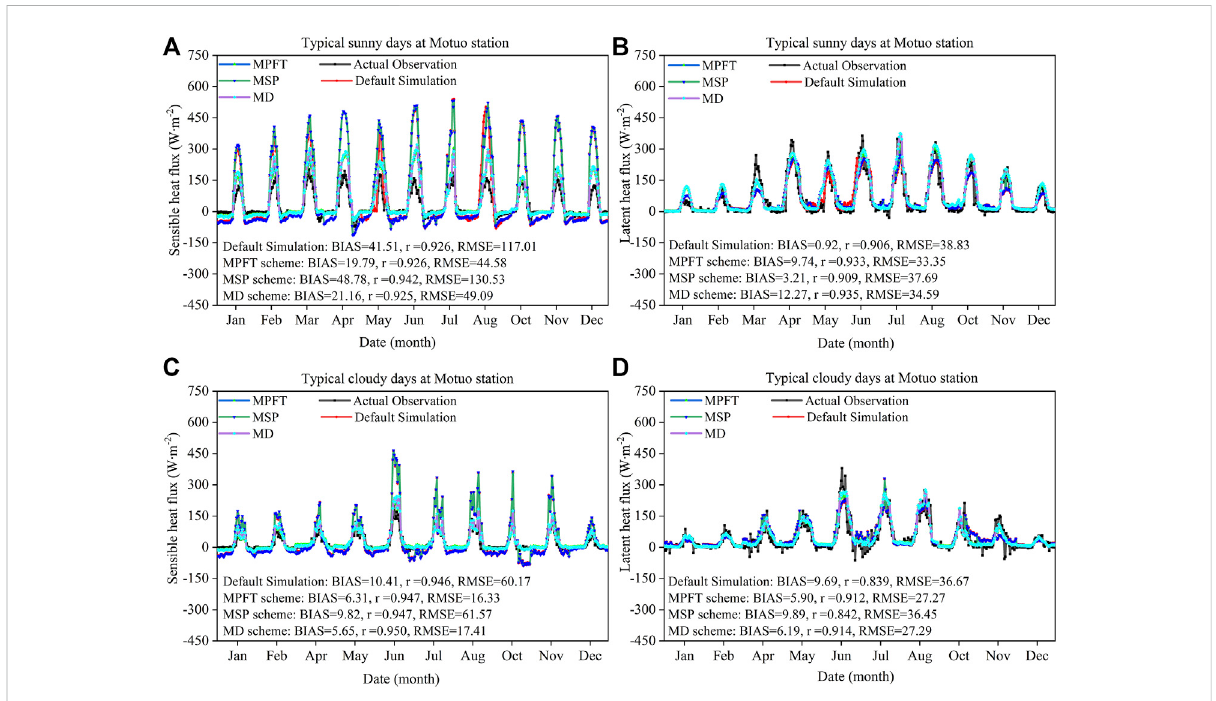
FIGURE 3 Comparison of turbulent fl uxes between the original and revised versions of CLM5.0 against observations on the typical sunny/cloudy days at Motuostation,whereBIASrepresentsthesimulationdeviation,RMSEistherootmeansquareerror,and r isthecorrelationcoef fi cient, (AandC) H, (B and D) LE, unit: (W · m − 2